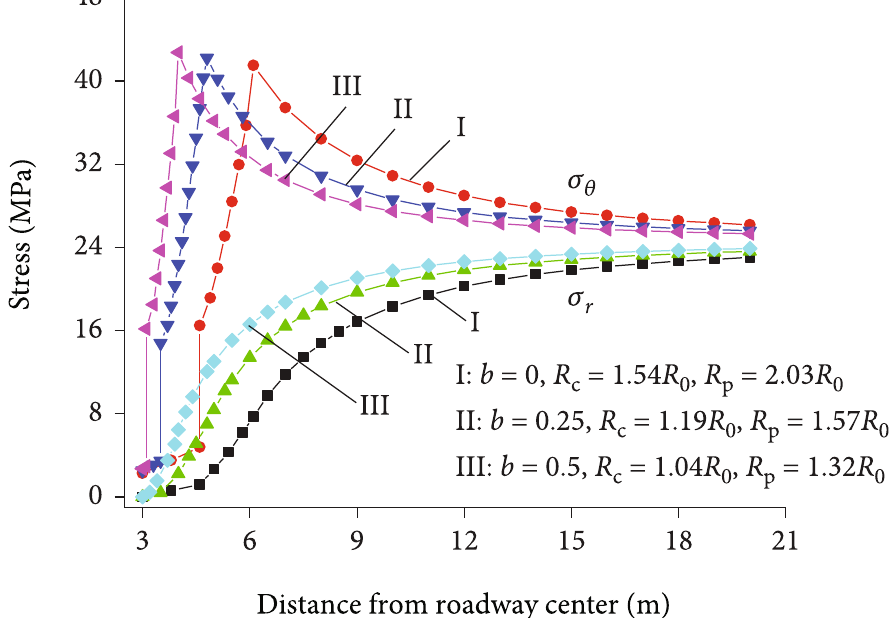
Figure 7: Stress distribution curve of surrounding rock in